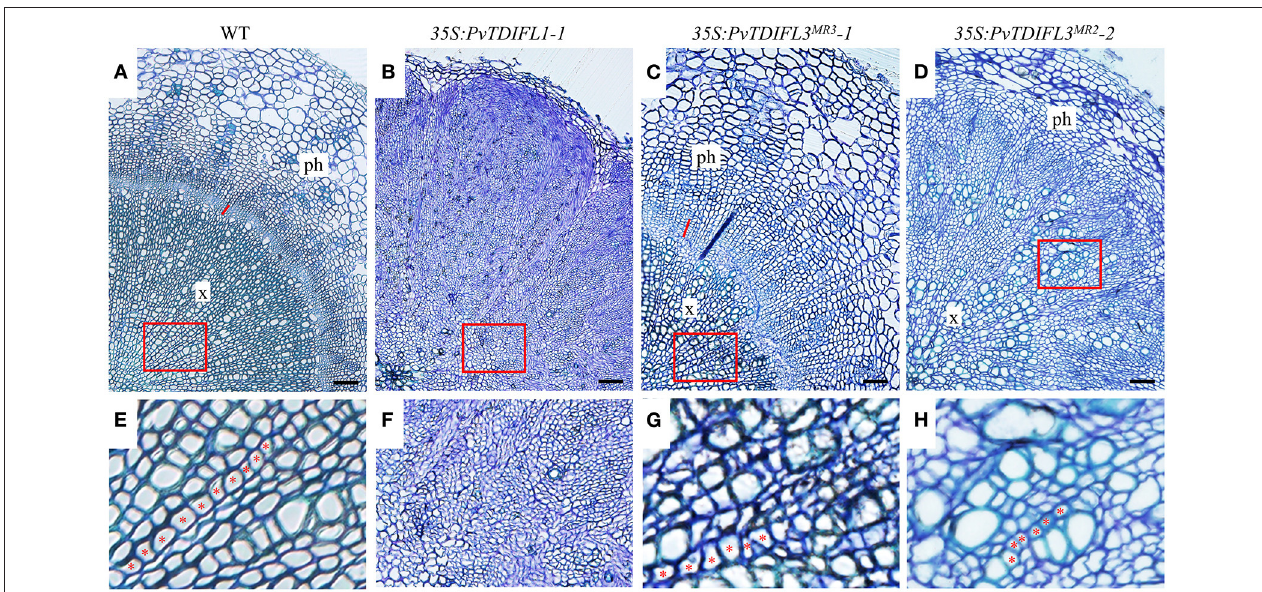
FIGURE 7 | Histology of 6-week-old Arabidopsis lines expressing PvTDIFL transgenes. (A–D) Histological observation of hypocotyls from WT (A) and transgenic seedlings harboring 35S:PvTDIFL1-1 (B) , 35S:PvTDIFL3 MR 3 -1 (C) , and 35S:PvTDIFL3 MR 2 -2 (D) transgenes. Transverse sections that were 2.5 µ m thick were stained with 0.05% (w/v) aqueous toluidine blue. Bar = 50 µ m. × and ph indicate xylem and phloem, respectively. The red line indicates cambium in (A) and (C) . (E–H) High magnification images from the areas in red boxes from (A–D) , respectively. Red asterisks show examples of organized files of